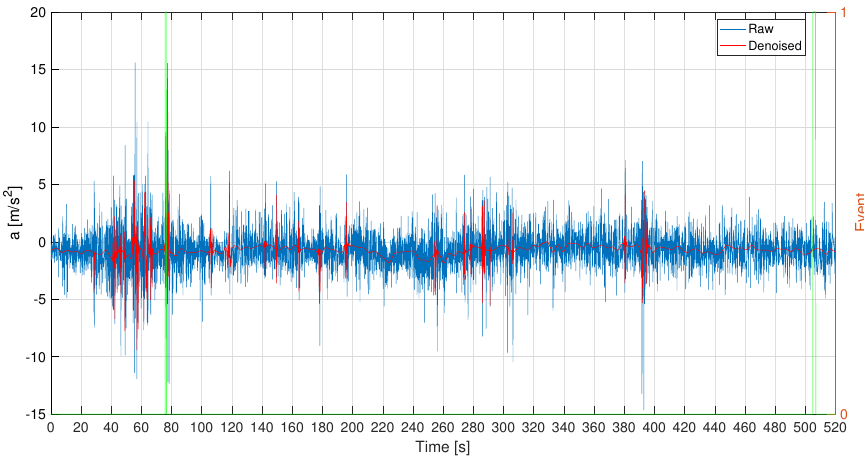
Figure 18. L1—HIMU acceleration signals: raw and denoised. Events are reported as pulsed train (green solid line).